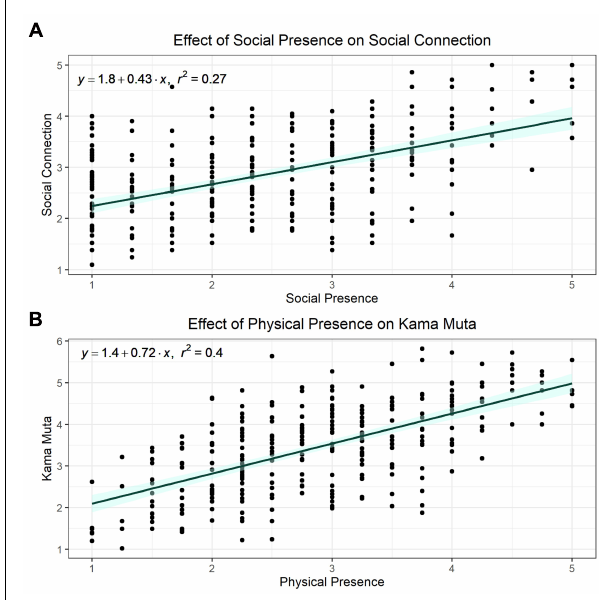
FIGURE 5 | The effect of (A) social presence on social connection and (B) physical presence on kama muta and their regression